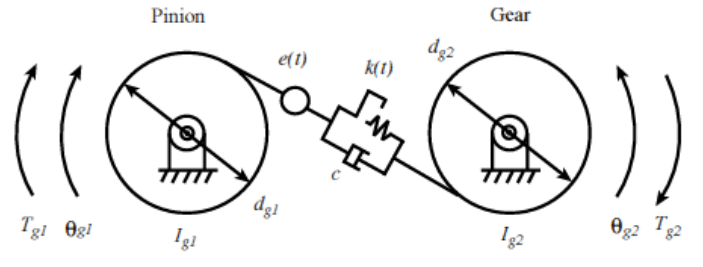
Figure 10. Dynamic model of spur gear pair